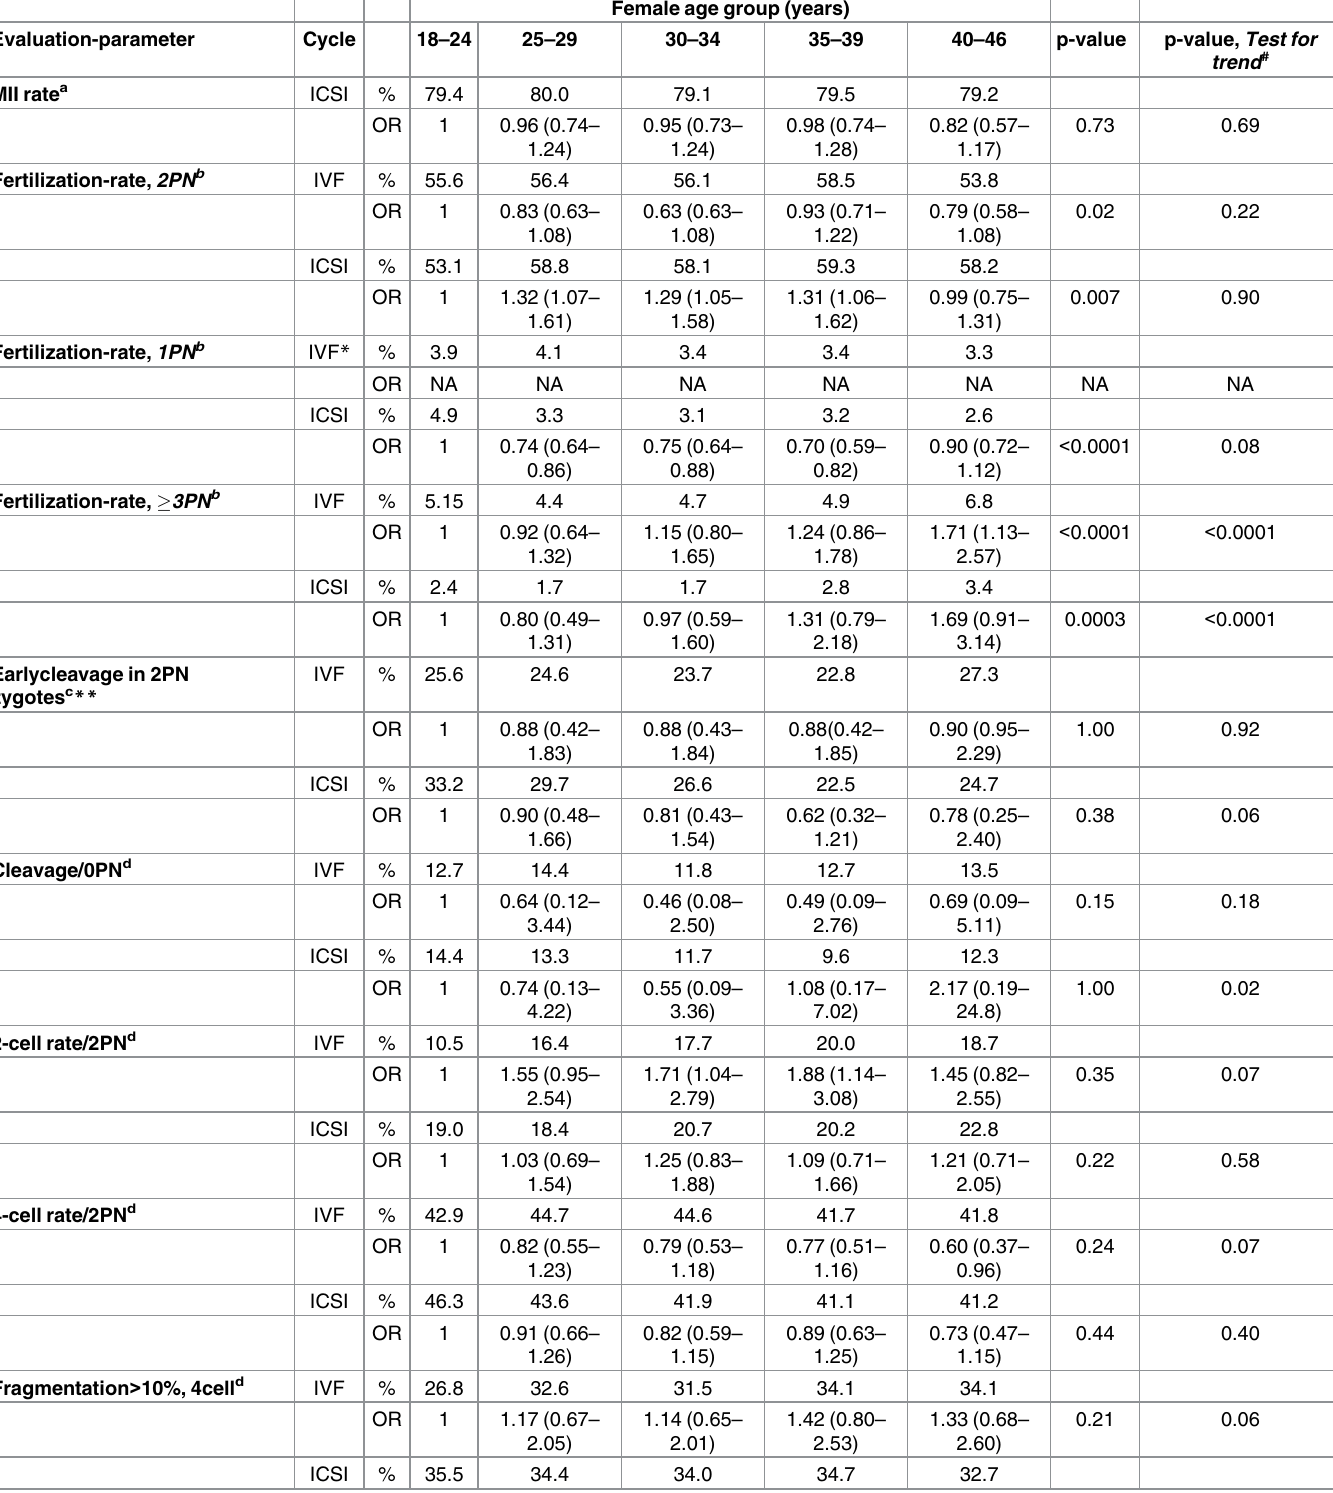
Table 3. Effect of women’s age on key morphology and cleavage evaluation parameters in oocyte, zygote and embryo in 5,650 IVF and 6,094 ICSI